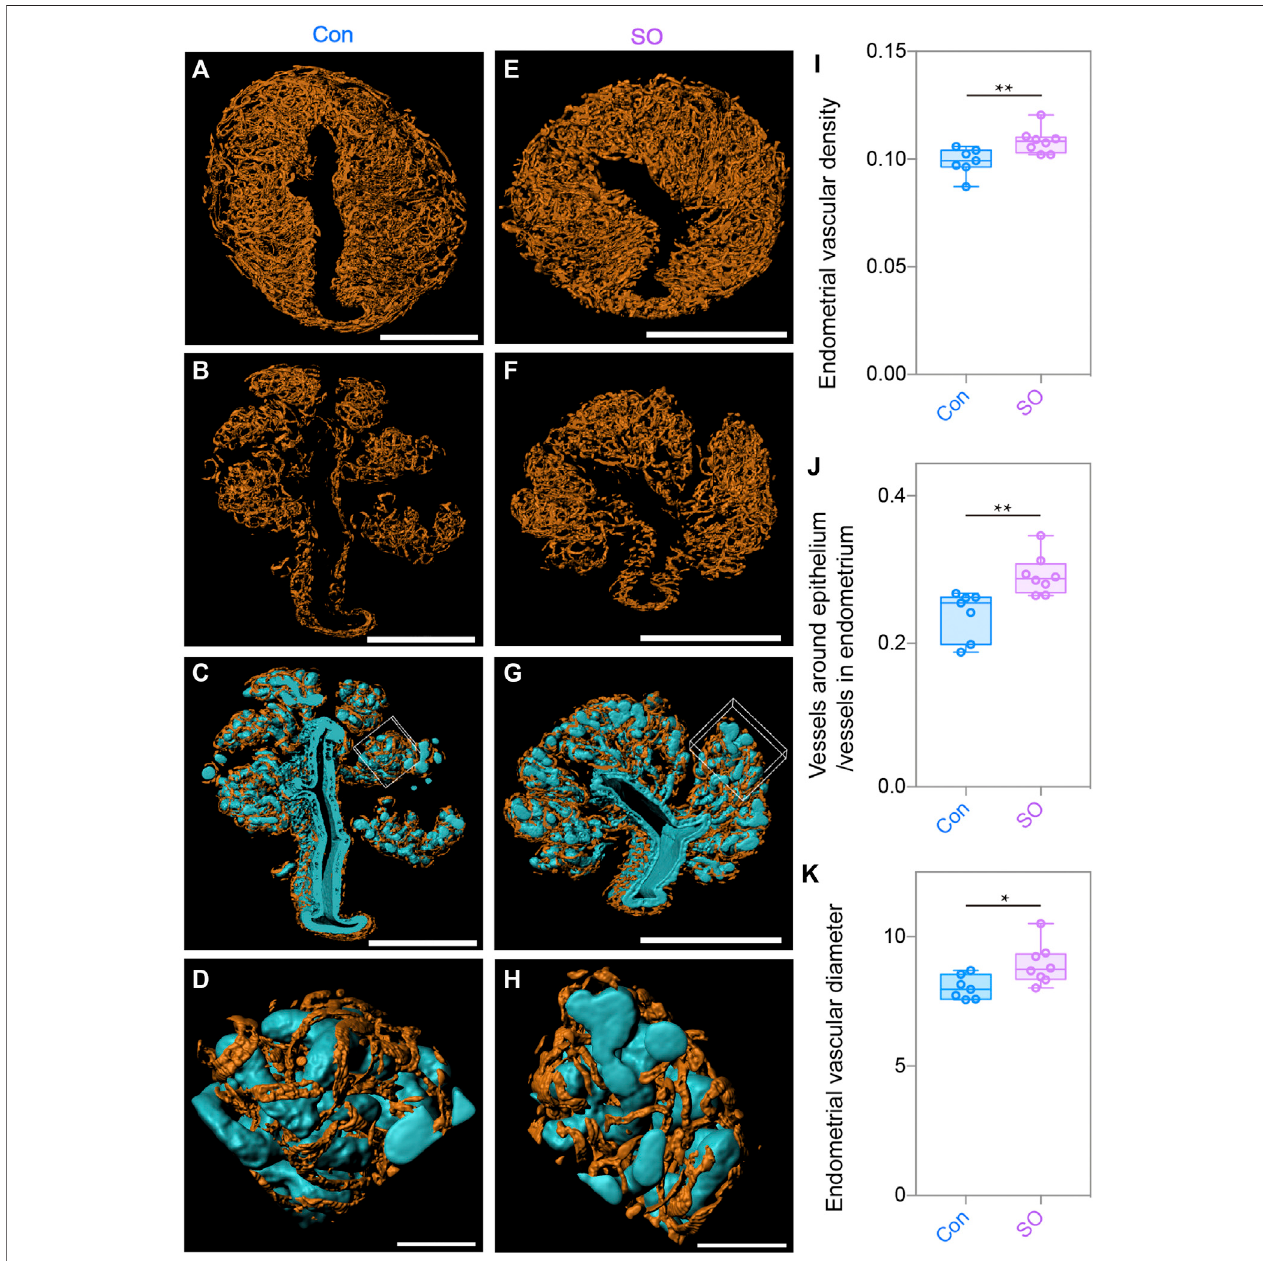
FIGURE 3 | Uterine endometrial angiogenesis in the 3D level after superovulation. (A) 3D rendering of the endometrial blood vessels of the control group. (B) 3D rendering of the vessels around the epithelium in the control group. (C) Blood vessels closely surrounded the epithelium in the control group. (D) Magni fi ed detail at the boxed area of (C) . (E) 3D rendering of endometrial blood vessels of the superovulation group. (F) 3D rendering of vessels around the epithelium in the superovulation group. (G) Blood vessels closely surrounding the epithelium in the superovulation group. (H) Magni fi ed detail at the boxed area of (G) . (I) Comparing endometrial vascular density in the control and superovulation groups. (J) Comparing the ratio of the vessels around the epithelium/vessels in the endometrium in the control and superovulationgroups. (K) Comparingtheendometrialvasculardiameterinthecontrolandsuperovulationgroups.Scalebarof (A – C,E – H) =350 μ m.Scalebarof (D,H) = 60 μ m. The results are shown as means ± SEM. * p < 0.05, ** p < 0.01, *** p < 0.001, **** p < 0.0001. n ≥ 7.